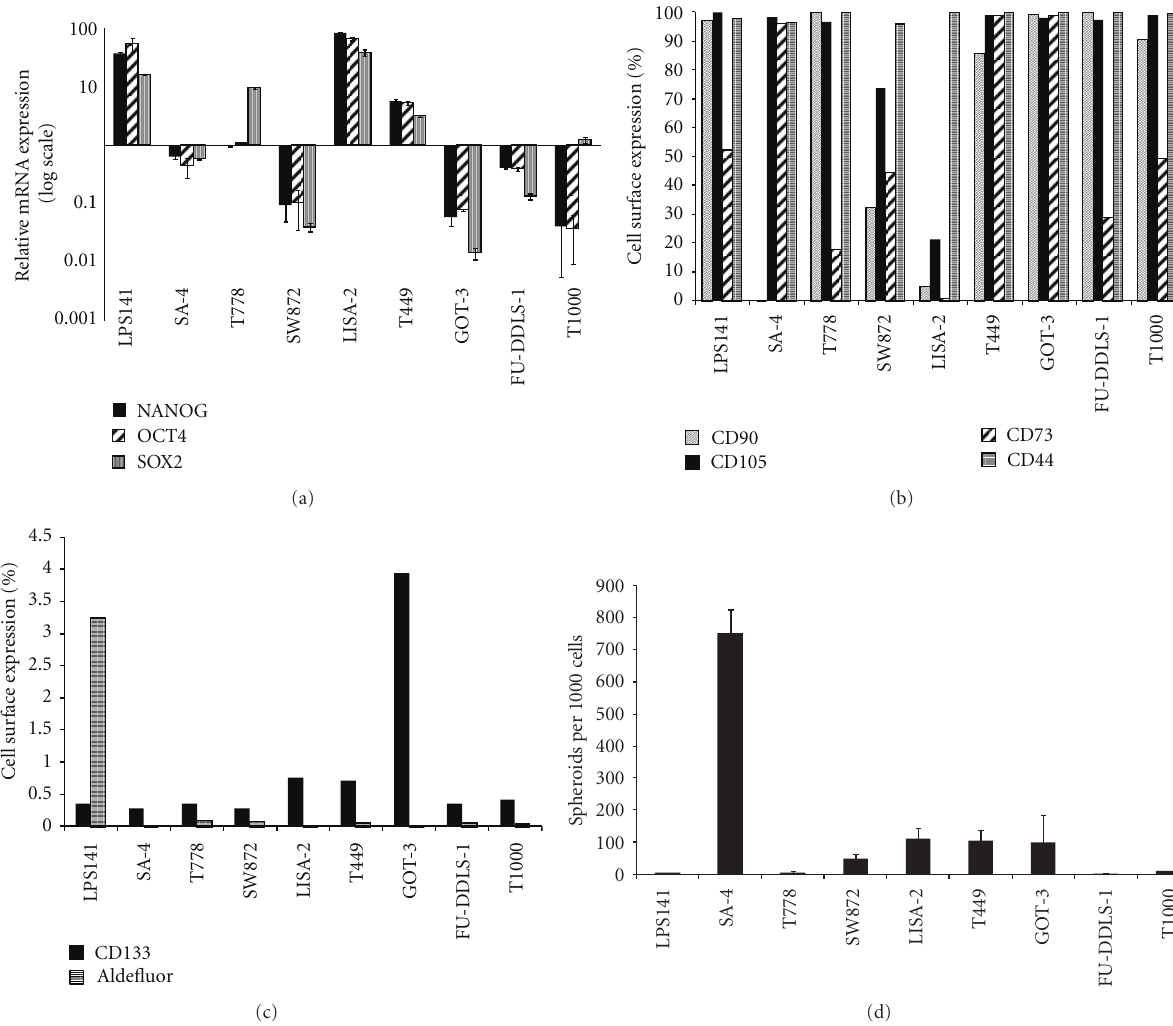
Figure 4: Stem cell phenotypes of the LPS cell lines. (a) NANOG, OCT4 , and SOX2 (normalized to TBP ) were determined by qRT-PCR and presented relative to the average expression of each gene (log scale). (b) Cell surface protein expression of CD90, CD105, CD73, and CD44 was determined by flow cytometry. (c) Expression of CD133 and Aldefluor activity was determined by flow cytometry. (d) Colony-forming ability is presented as colonies > 50 μ m generated from 1000 cells, following 14 days culturing in semi-solid medium.